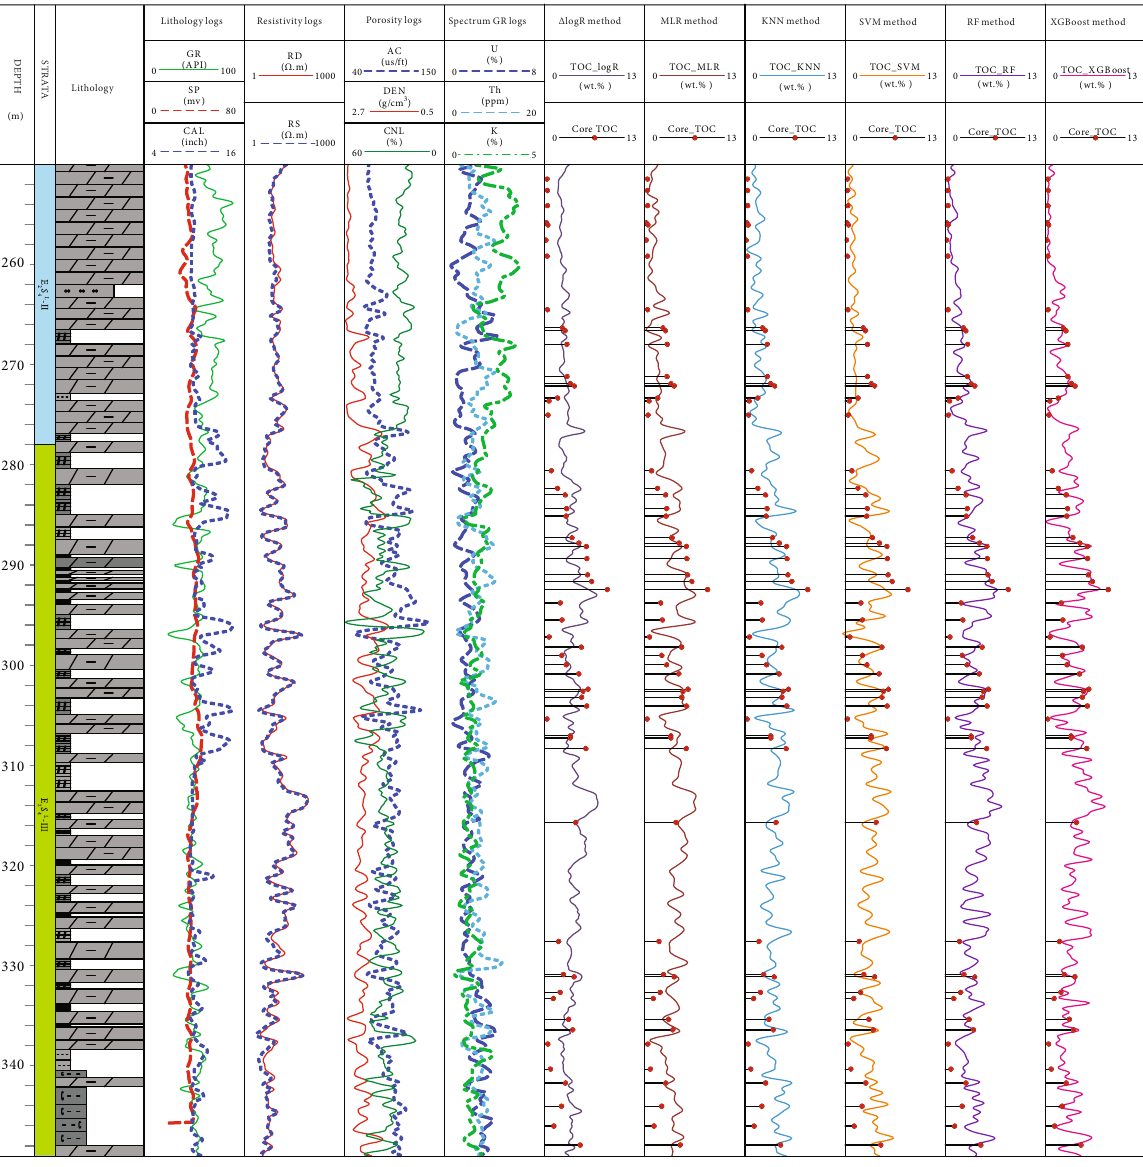
L -II group and E s 2 4